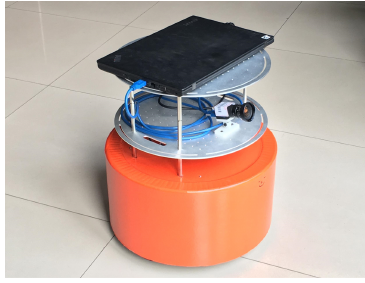
Figure 5. Redbot with a daheng monocular